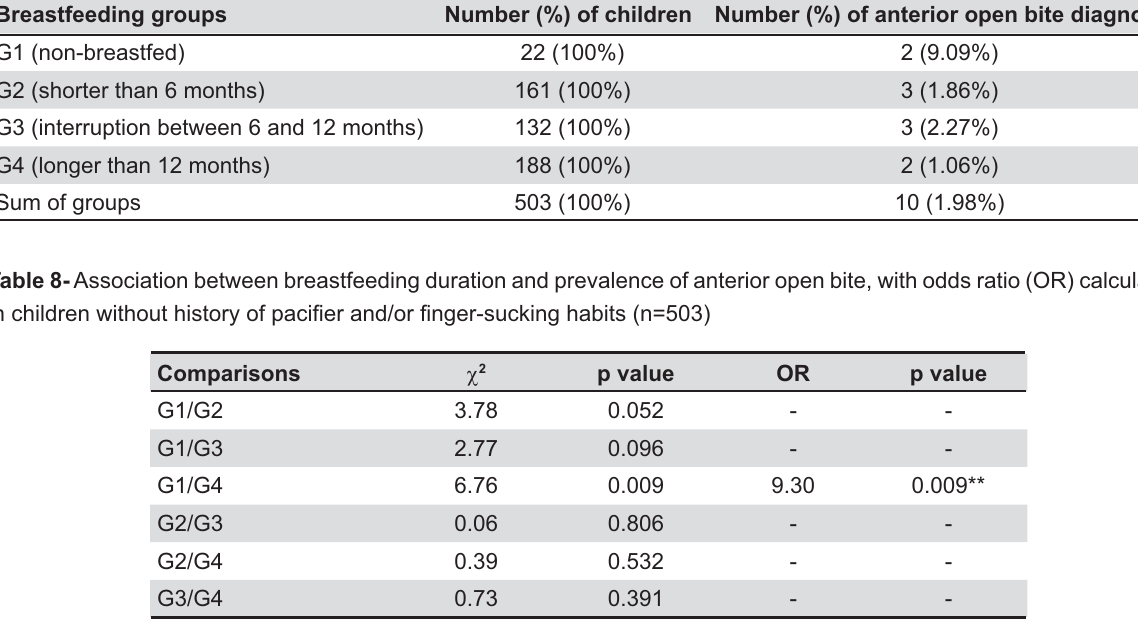
G1: non-breastfed. G2: shorter than 6 months. G3: interruption between 6 and 12 months. G4: longer than 12 months. c2: chi-square value. **: p value<0.01